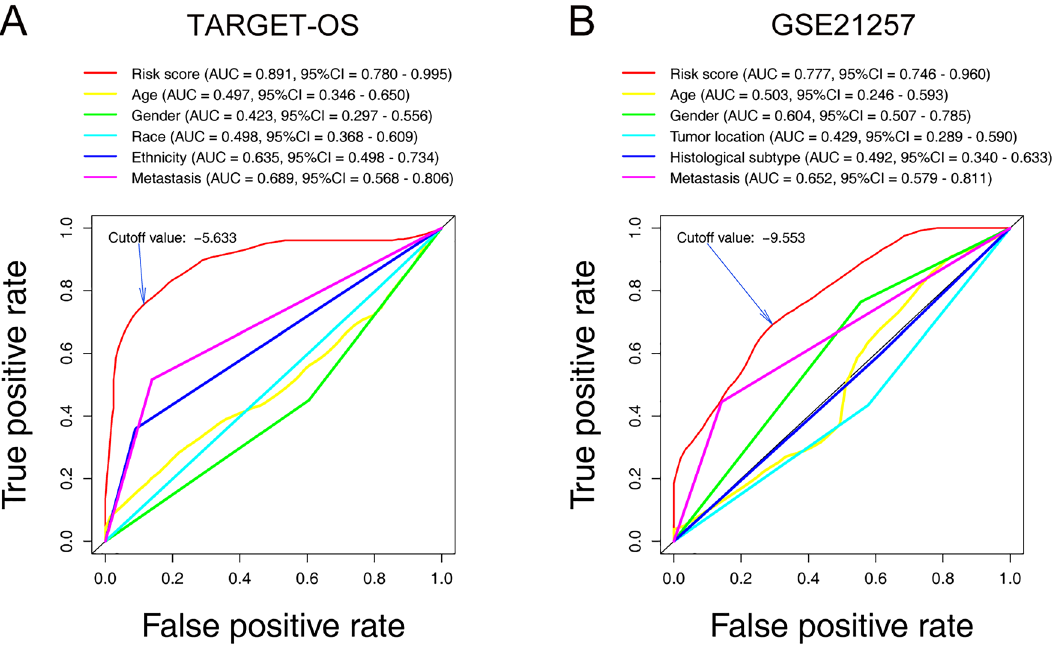
Figure 6. ROC curves that constructed for examining the predictive ability of the seventeen-gene signature in the training ( A ) and validation ( B ) cohorts. ROC receiver operating characteristic, AUC area under the ROC curve, 95% CI 95% confidence interval.